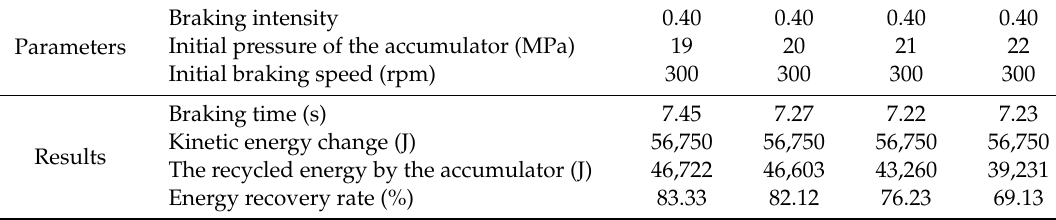
Figure 14. Experimental results with the different initial pressure of the accumulator: ( a ) Evolution of speed of the flywheel, ( b ) Evolution of pressure of the accumulator. Table 7. Experimental results in operating mode with di ff erent initial pressure of the accumulator.